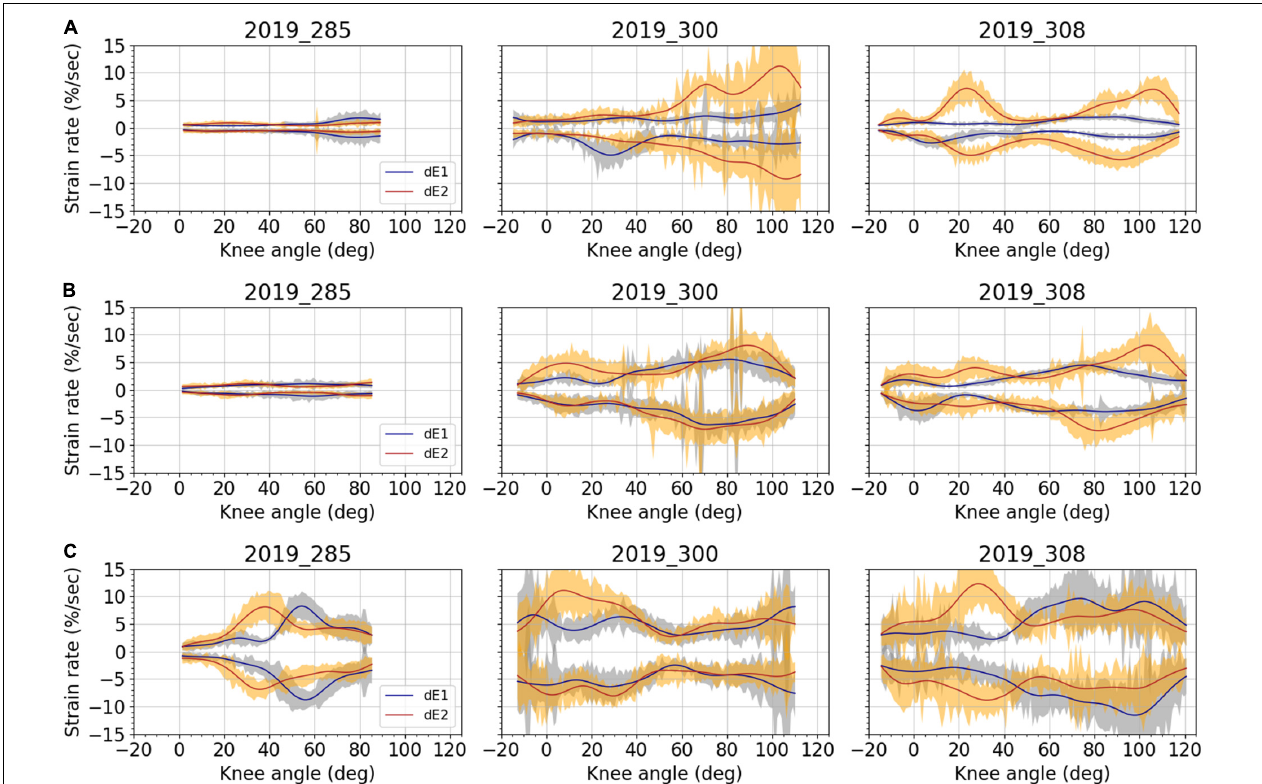
FIGURE 10 | Averaged strain rates and corresponding standard deviation over the knee angles for all subjects: (A) anterior fascia; (B) lateral fascia; and (C) ITT. Blue curves and light blue areas correspond respectively to average strain rate and standard deviation for major strain E 1 . Red curves and orange areas correspond respectively to average strain rate and standard deviation for minor strain E 2 . Data were filtered using a forward-backward linear filter. Filter coefficients were obtained from a low-pass digital Butterworth filter (3rd order, cut off frequency of 2Hz) that was first applied on